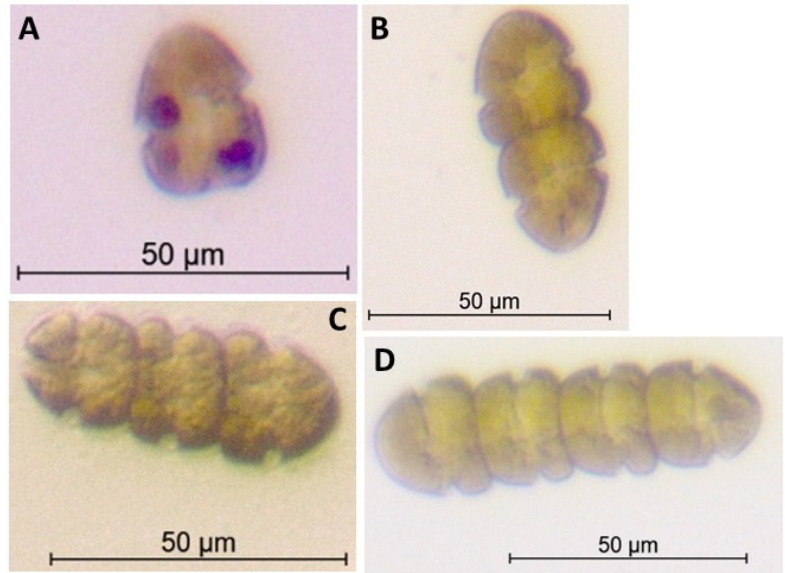
Figure 3 . Live cells of G. impudicum strain Gy.imp1. ( A ) Single cell showing chloroplasts. ( B ) Ventral view of a pair of cells showing cingular displacement. ( C ) Dorsal view of a chain of three cells in which the posterior cell is much larger than the anterior one. ( D ) Dorsal view of a chain of four cells in which the epicones are clearly larger than the hypocones. The size of the cells increases towards the posterior end of the chain.